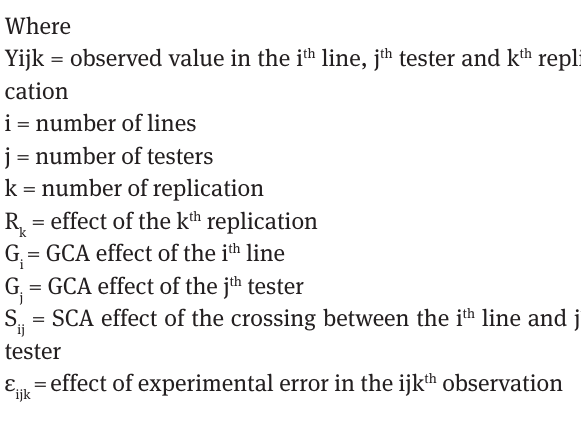
Table 2: Coordinates and average temperature of the experimental sites for potato field experiments in Peru